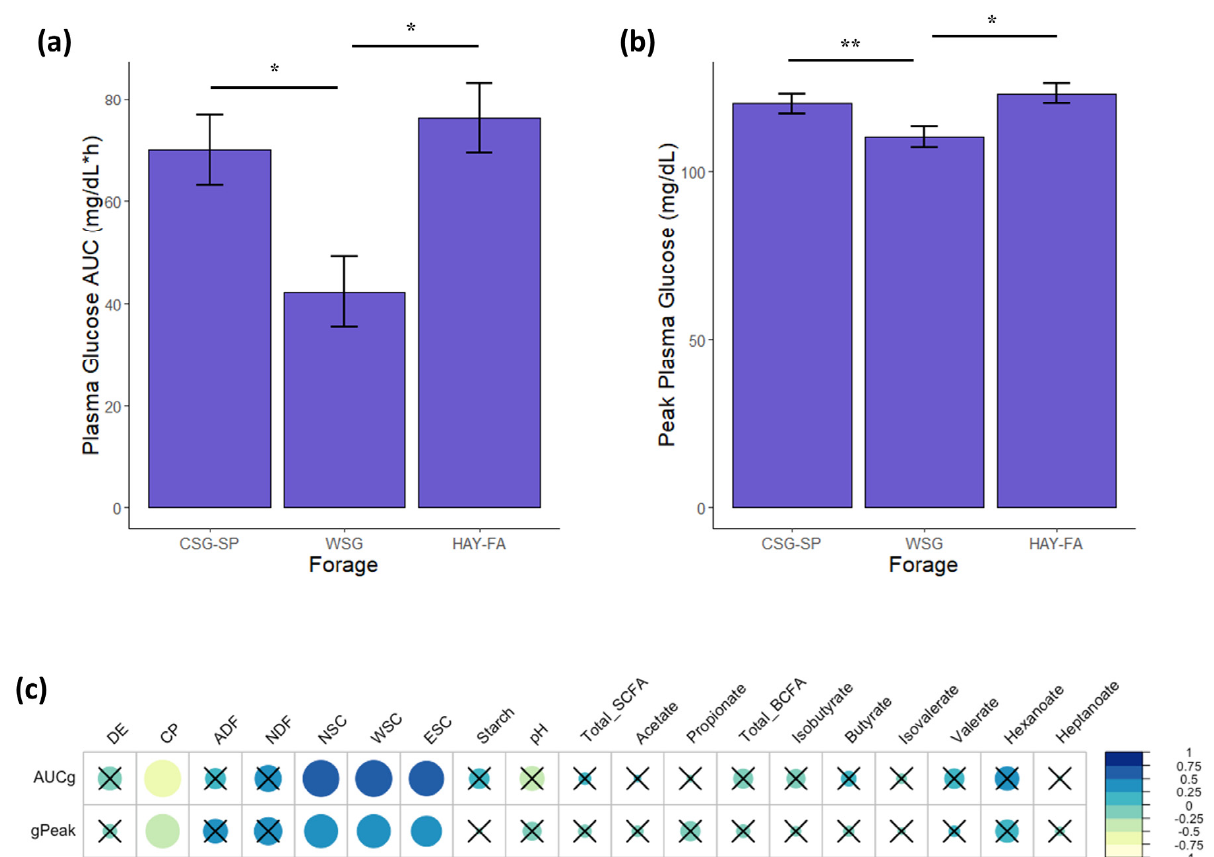
Figure 7. Plasma glucose responses to oral sugar tests and relationship with forage nutrients and fermentation metabolites. Oral sugar tests were administered to horses adapted to spring cool-season grass pasture (CSG-SP) and warm-season grass in the summer slump period (WSG) in addition to a standardized hay diet in the fall at the end of the grazing season (HAY-FA). Glycemic responses including the positive incremental area under the curve ( a ) and peak plasma glucose ( b ) are presented as least squares means ± SEM. A single asterisk indicates differences between forages at p ≤ 0.05 (mixed model ANOVA with Tukey’s post hoc adjustment). A double asterisk indicates a trend for differences at p ≤ 0.10. ( c ) Correlated nutrients included digestible energy (DE), crude protein (CP) acid detergent fiber (ADF), neutral detergent fiber (NDF), non-structural carbohydrate (NSC), water-soluble carbohydrate (WSC) and ethanol-soluble carbohydrate (ESC). Fecal metabolites included short- and branched-chain fatty acids. Significance of Spearman correlations was set at r s ≥ |0.30| ( p ≤ 0.05). An “X” indicates non-significant correlations. Color and size of circles within cells are mapped to direction and strength of correlation. Larger, darker blue circles indicate a stronger positive correlation (closer to r s = 1.0); larger, lighter yellow circles indicate a stronger negative correlation (closer to r s = − 1.0).